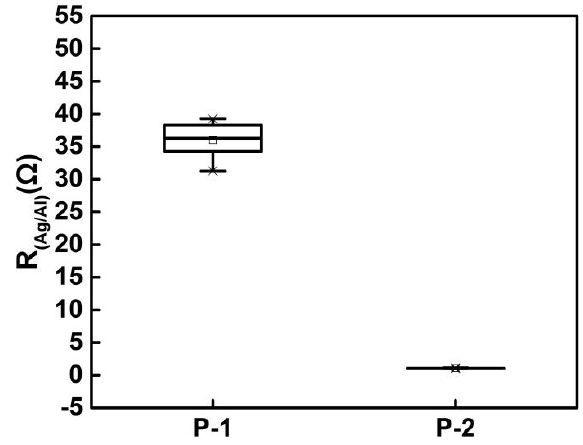
Figure 2. The chart of Ag/Al electrode contact resistance.